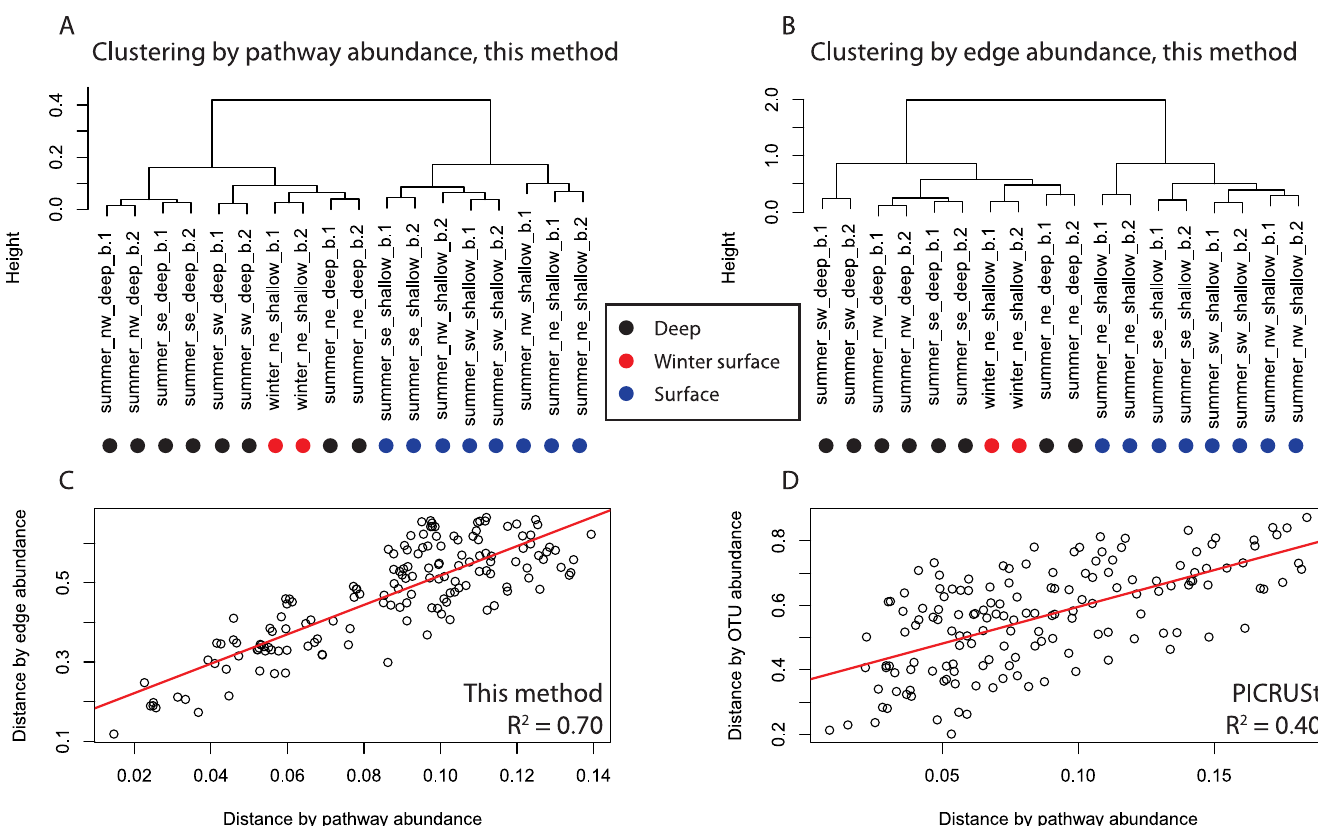
Fig 4. Hierarchical clustering of samples by pathway and edge abundance. Clustering used the Ward algorithm on Bray-Curtis distance. A) Hierarchical clustering by pathway after normalization to the maximum abundance of each pathway. B) Hierarchical clustering by edge abundance after normalization to the total abundance of each sample. C) Linear model (red line) for distance by edge abundance as a function of distance by pathway abundance, R 2 = 0.65, df = 75, p (cid:4) 0. D) Linear model (red line) for distance by OTU abundance as a function of distance by pathway abundance, as predicted using PICRUSt (see text)